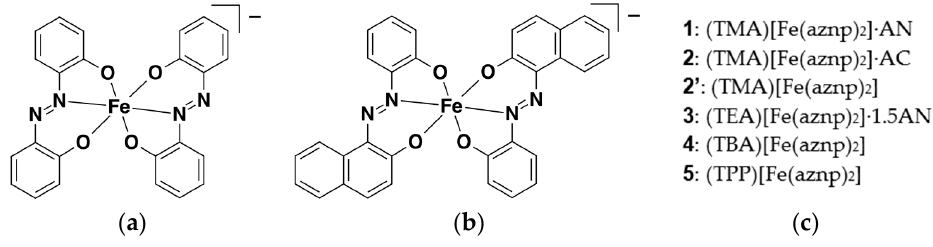
Figure 1. Molecular structures. ( a ) [Fe III (azp) 2 ] anion; ( b ) [Fe III (aznp) 2 ] anion; and ( c ) the numberings and formula of compounds 1 – 5 . TMA = tetramethylammonium, TEA = tetraethylammonium, TBA = tetrabutylammonium, TPP = tetraphenylphosphonium, AN = acetonitrile, AC = acetone.